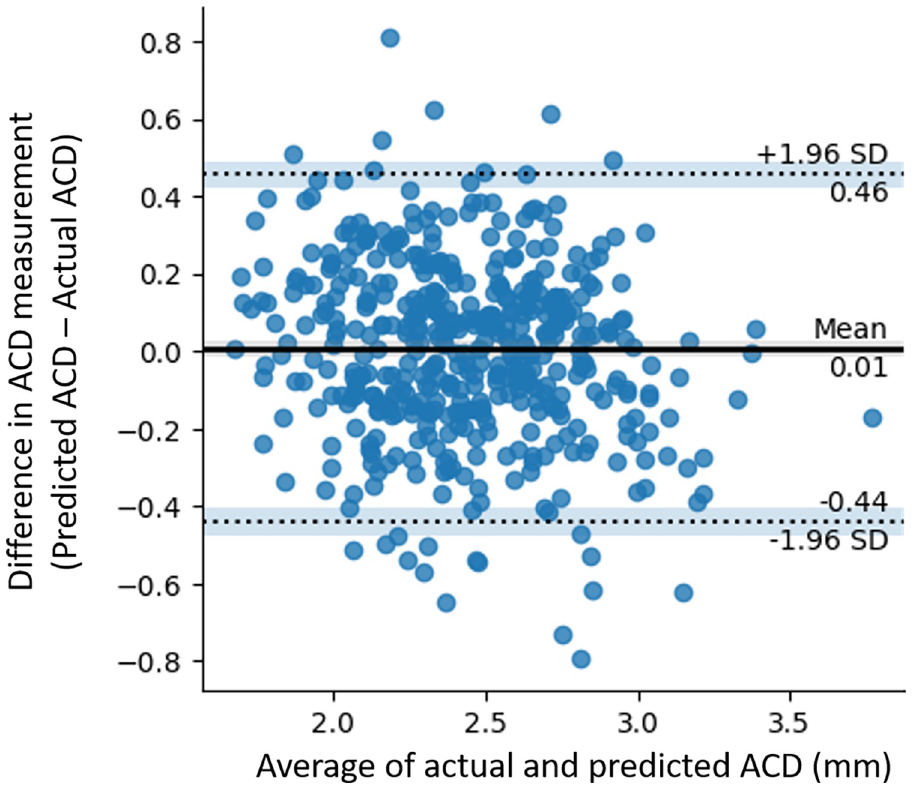
Fig 2. Bland-Altman plot illustrating the agreement between actual and predicted anterior chamber depth (ACD) measurements in algorithm validation.